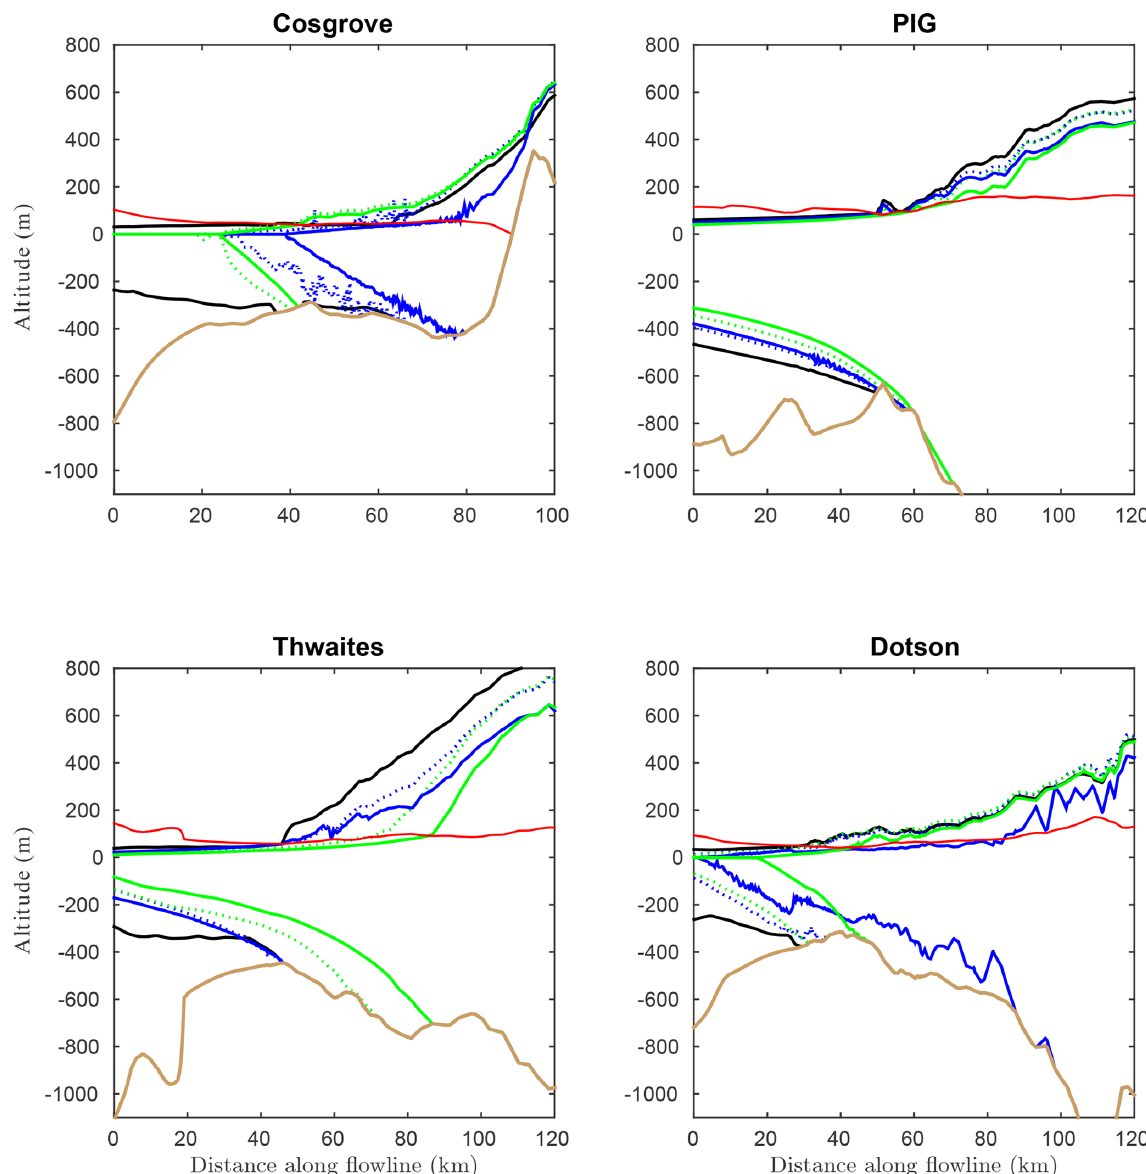
Figure 9. Ice-sheet profiles obtained for the inferred state I R at t = 0a (black solid line), t = 55a (coloured dotted line) and t = 105a γ, 100 (coloured solid line) of EXP_ABMB with the Schoof law associated with C max = 0 . 4 (green) and the non-linear Budd law (blue), along the flow lines reported in Fig. 8. The solid light-brown line is the bed elevation. The red solid line is the flotation altitude z f , given by z f = ( 1 − ρ w /ρ i )b